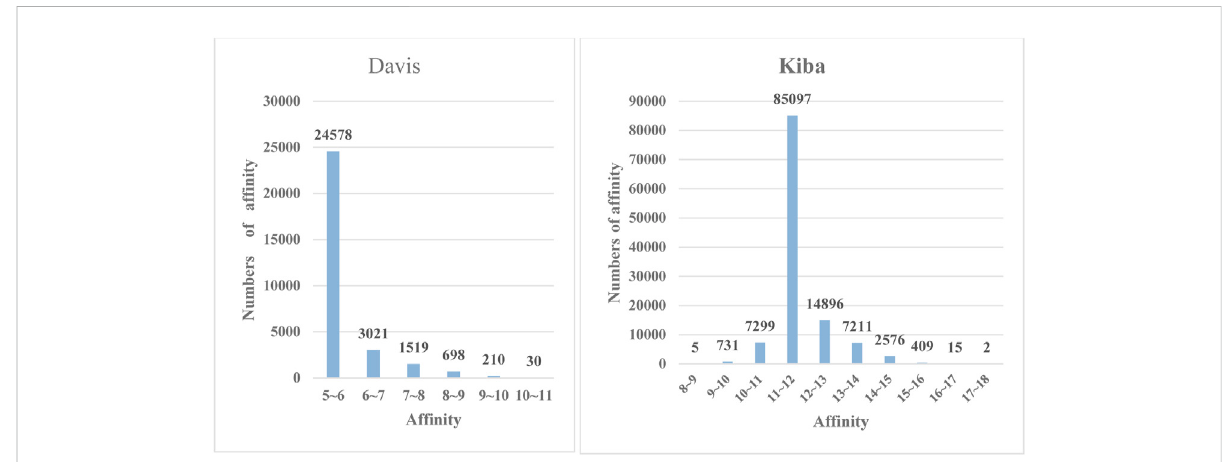
FIGURE 4 The frequency histograms of the af fi nities in the Davis and KIBA datasets. The horizontal axis denotes the af fi nity values of drugs and proteins, and the vertical axis represents the numbers of af fi nity values in certain